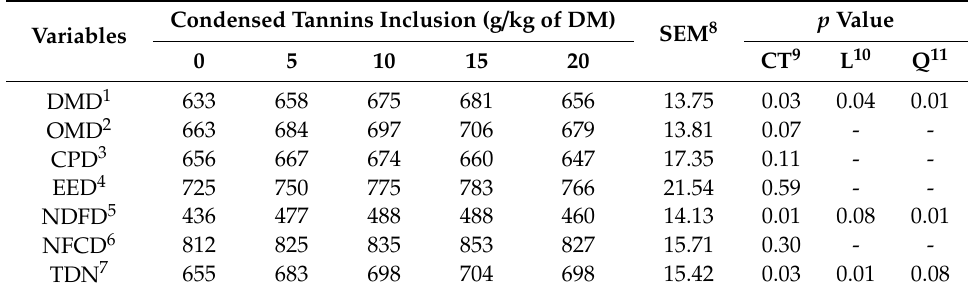
Table 4. Apparent digestibility of dry matter and nutrients (g / kg) of Holstein cows fed diets with five levels of condensed tannins from Acacia mearnsii.